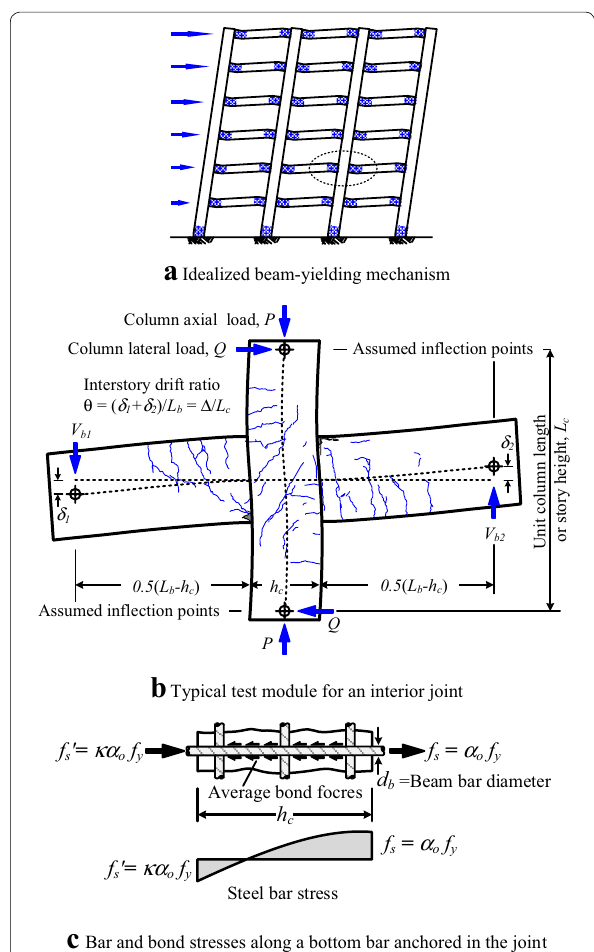
Fig. 1 Moment‑resisting frame joints with plastic hinges at the joint faces.